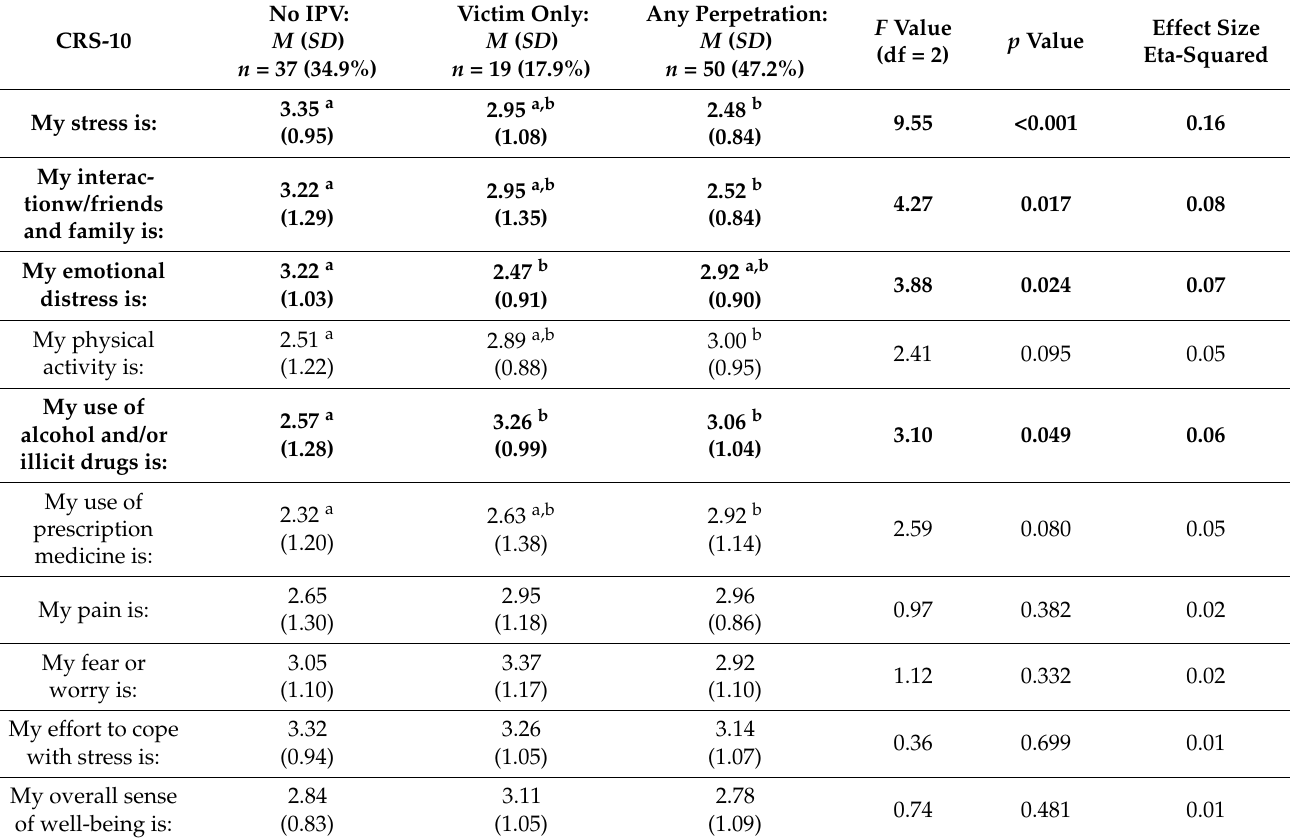
Table 5. Comparison of the three IPV groups on the CRS-10 Coronavirus Response